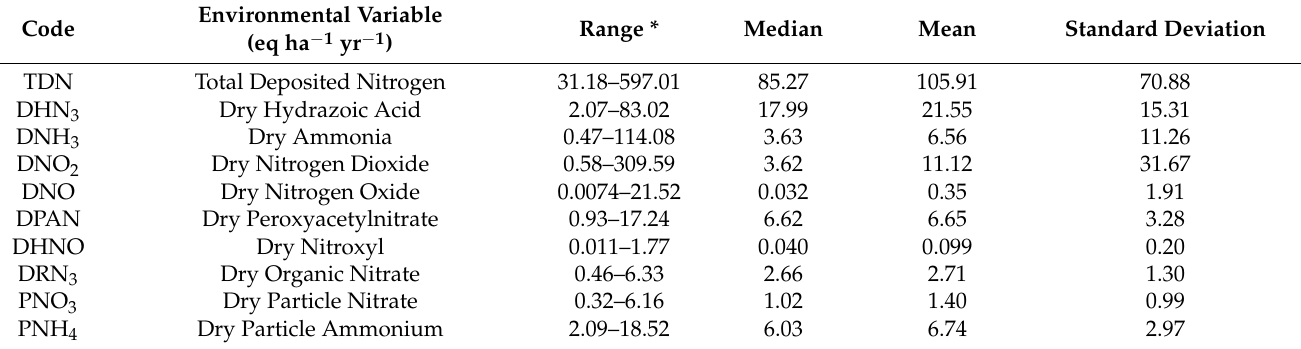
Table 1. List of nitrogen and sulphur species (n = 17) and their associated summary statistics across all 297 study sites (see Figure 1). Data source: GEM-MACH [45].